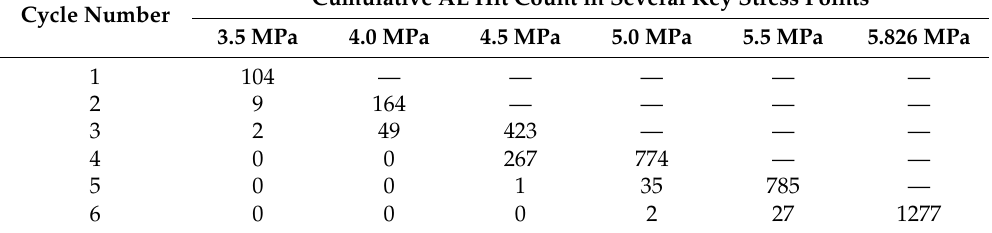
Table 2. The cumulative AE hit count of coal specimens at key stress points in different loading– unloading cycles.